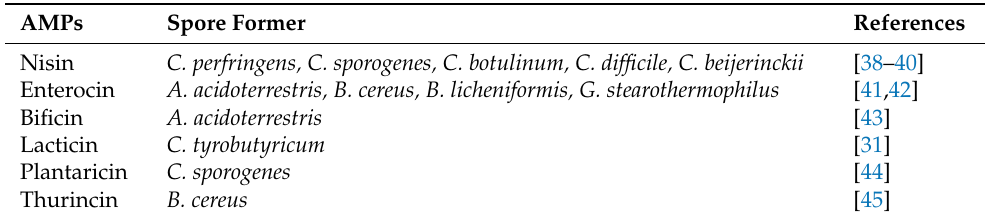
Table 1. Some examples of AMPs with activity against bacteria spore